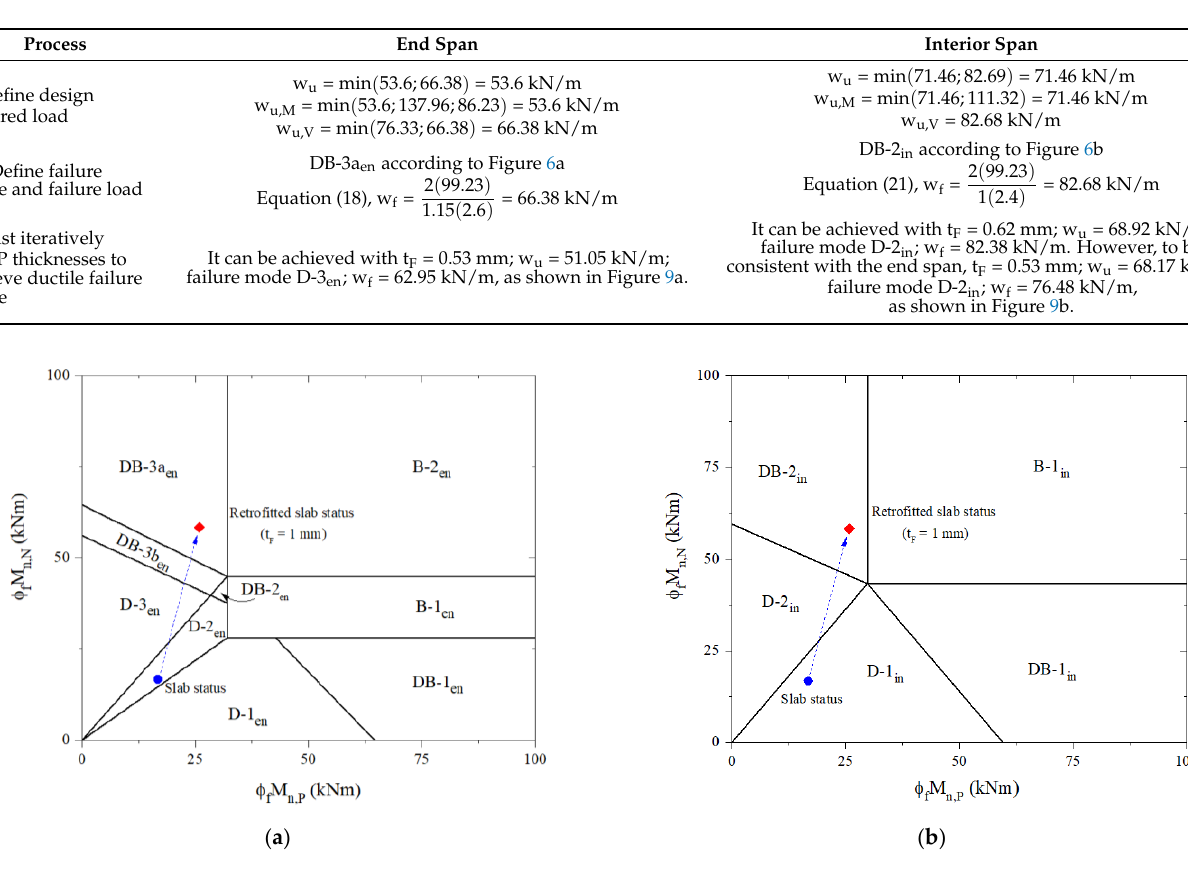
Figure 8. Predicting failure limits and failure mode for the retrofitted slab: ( a ) the end span; ( b ) the interior span.